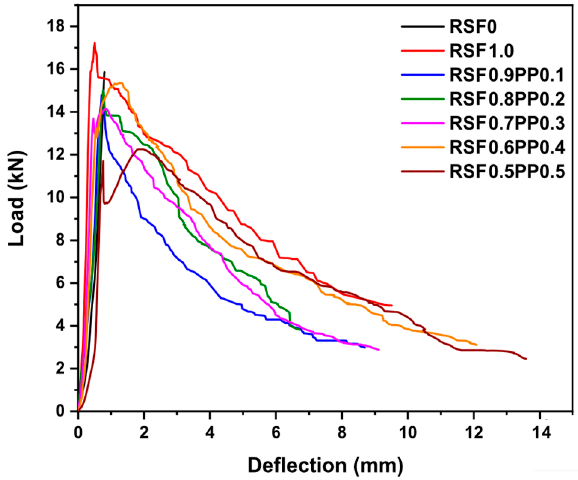
Figure 3. Load deflection curve for complex hybrid FRC. Adapted from [89].